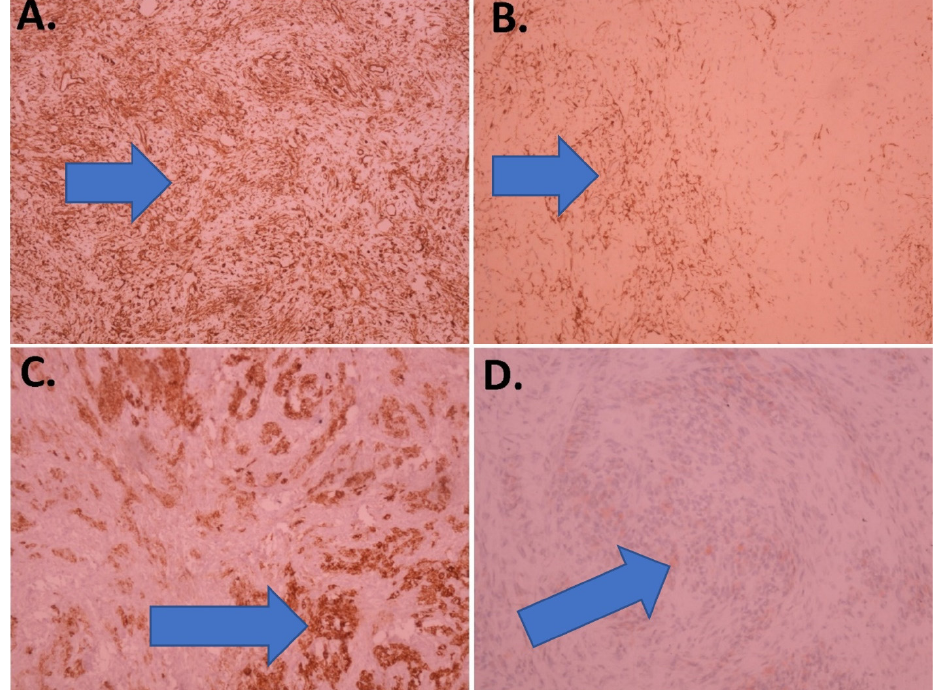
Figure 4. Immunohistochemical features of the fibrothecoma: ( A ) vimentin (100×); ( B ) actin (100×); ( C ) inhibin (100×); ( D ) oil red O (200×) (positive tumor cells—blue arrow).